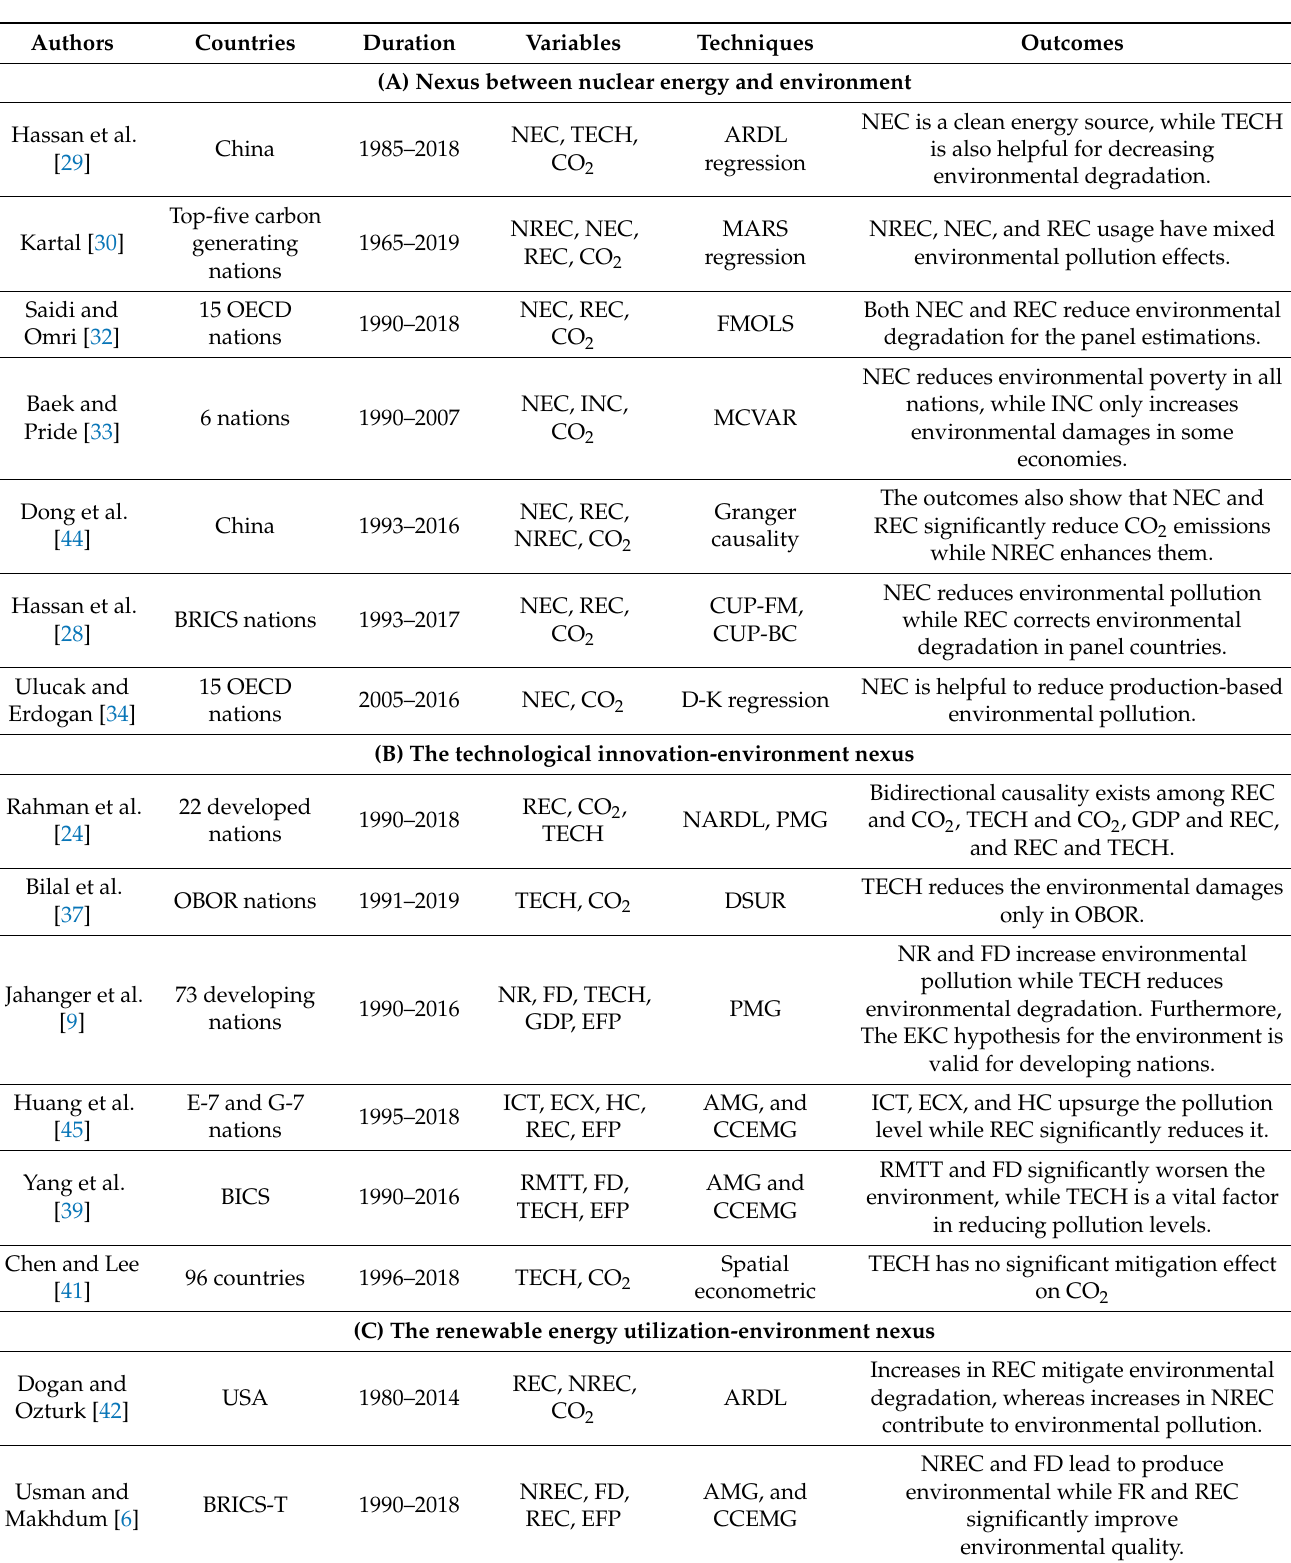
Table 1. Summary of the existing published literature between NEC, REC, and ERT-environment